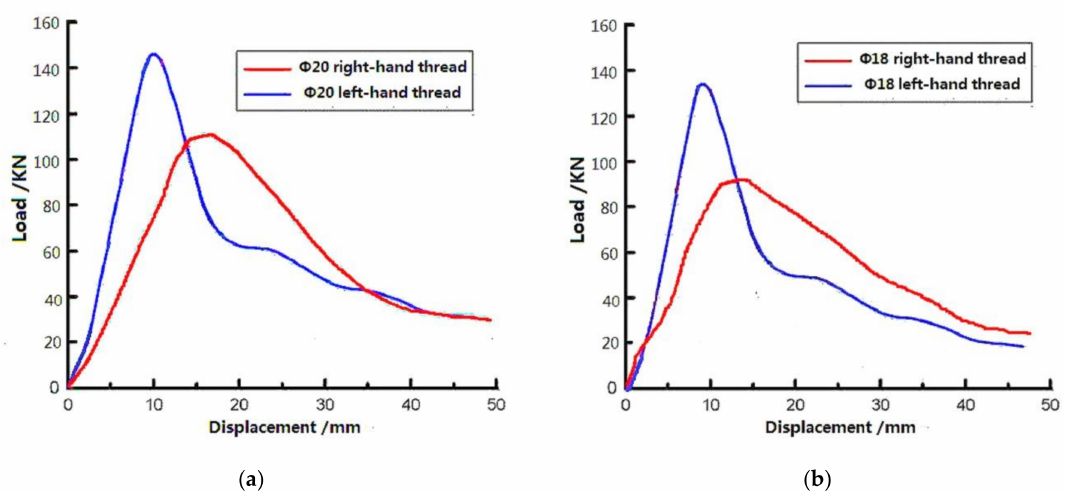
Figure 12. Displacement-load curves of the left-hand and right-hand threaded steel bolts. ( a ) Φ 20 thread steel bolts; ( b ) Φ 18 thread steel